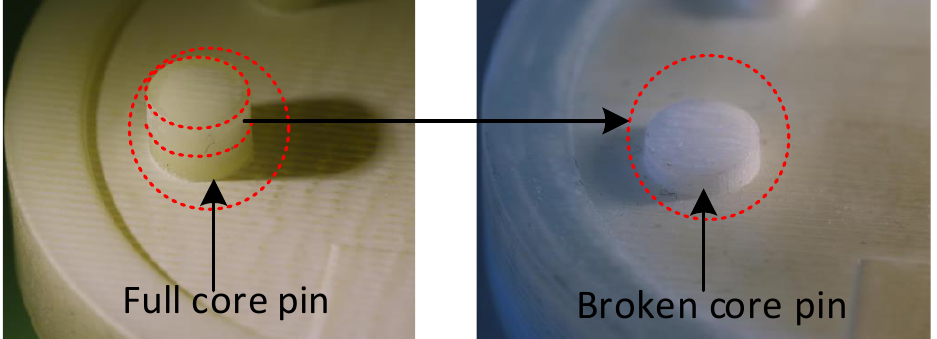
Figure 22. M5 core pin on the 3DIM tool printed using Visijet M3-X before moulding and after initial chipping failure on the 5th shot.